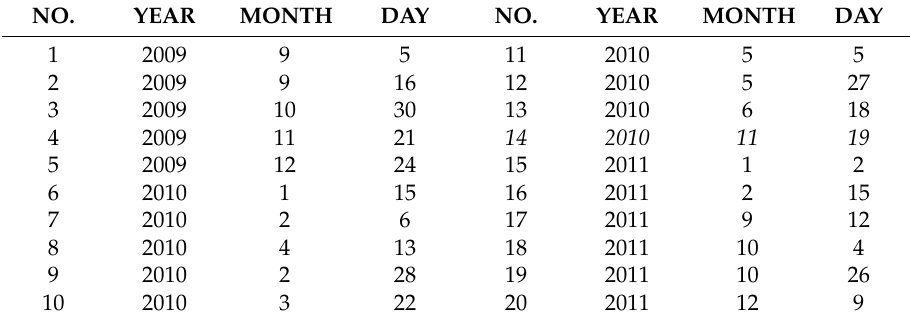
Table 1. Observation dates of 20 TerraSAR-X images. No. 14, in italic letters, represents the master image.